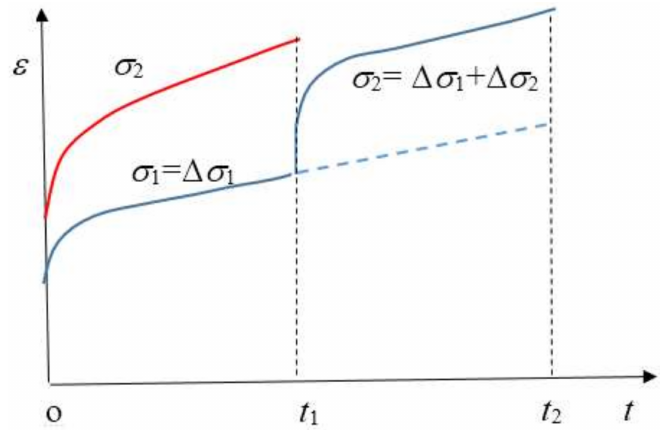
Figure 9. Illustration of creep strain expression considering time effect for the Burgers